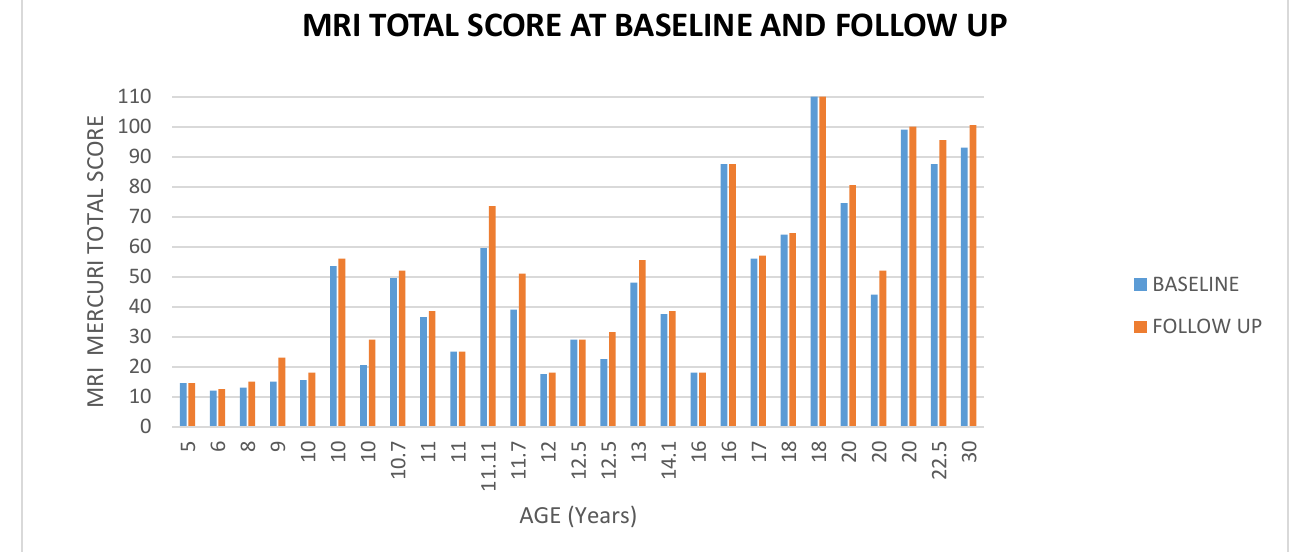
Figure 1. showed muscle MRI total score at baseline and at follow up according to age. Figure 1. Showed muscle MRI total score at baseline and at follow up according to